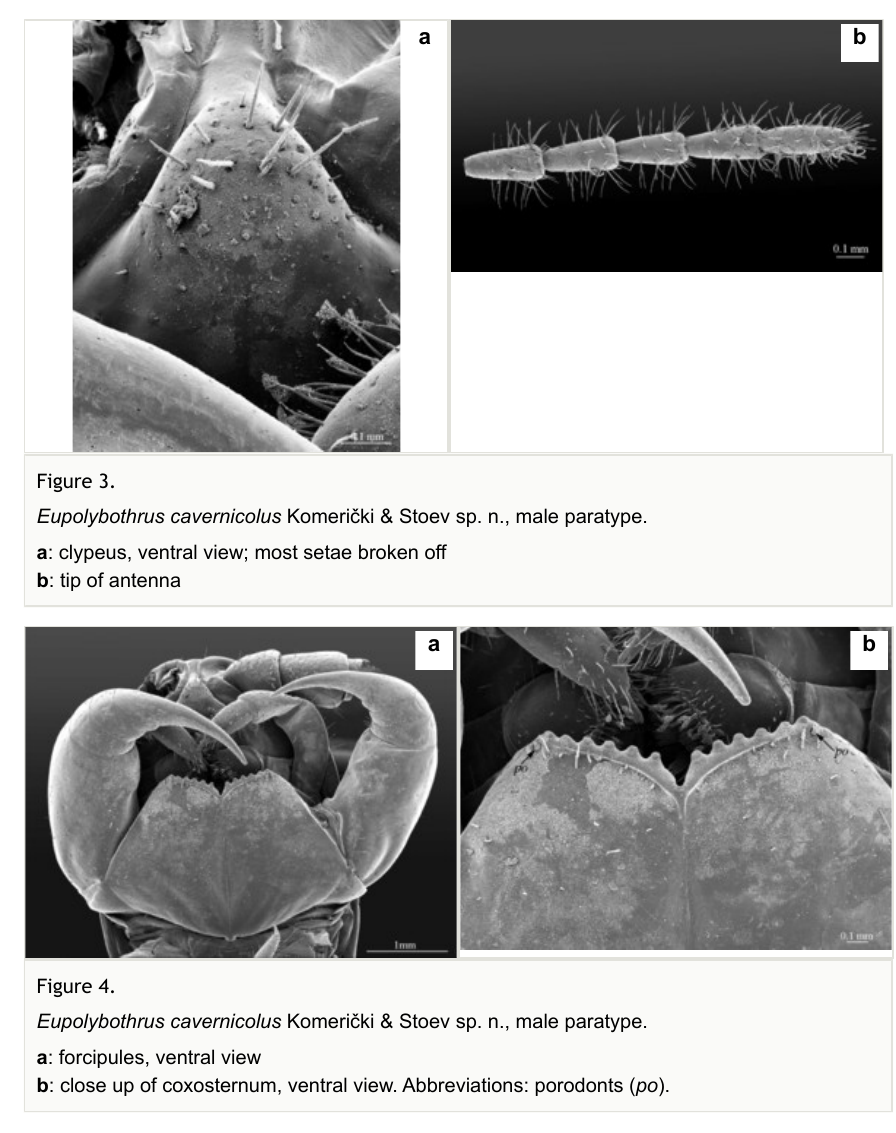
Tergites : T1 wider than long, subtrapeziform, wider anteriorly, posterior margin straight or slightly emarginated, marginal ridge with a small median thickening; TT3 and 5 more elongated than T1, posterior margin slightly emarginated medially, posterior angles rounded; posterior angles of T4 rounded; posterior margin of T8 slightly emarginated medially, angles rounded; TT6 and 7 with posterior angles abruptly rounded (Fig. 5a); TT9, 11, 13 with well-developed posterior triangular projections (Fig. 5b); posterior margin of TT10, 12, 14 slightly emarginated, posterior-most part densely setose; intermediate tergite subpentagonal, posterior margin deeply emarginated, lateral edges bent upwards, covered with setae; middle part of posterior third of tergite densely